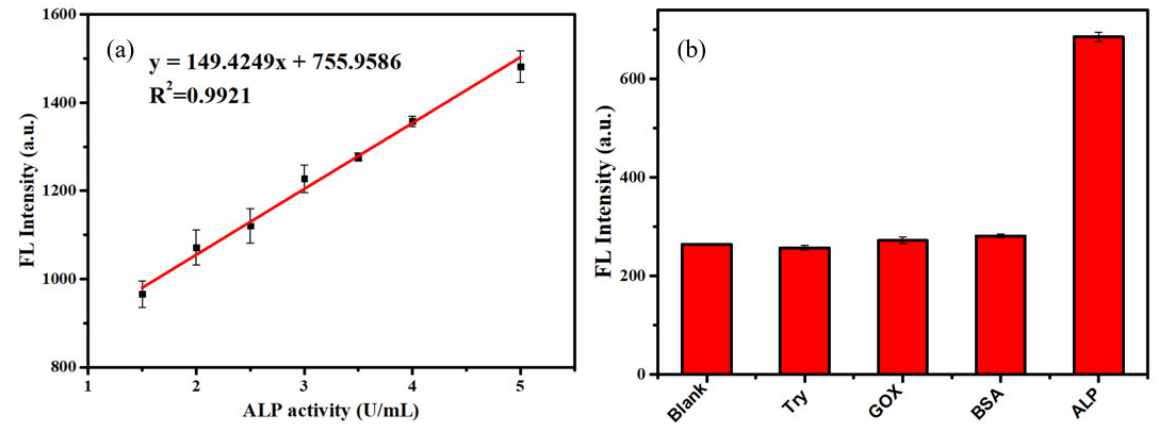
Figure 6. ( a ) Fluorescence response of the assay to ALP of different activities. Inset: linear response of SQDs to ALP in the activity range of 1.5–5.0 U/mL; ( b ) Selectivity of the assay to ALP. Table 1. Comparison employing fluorescent probes to detect ALP.